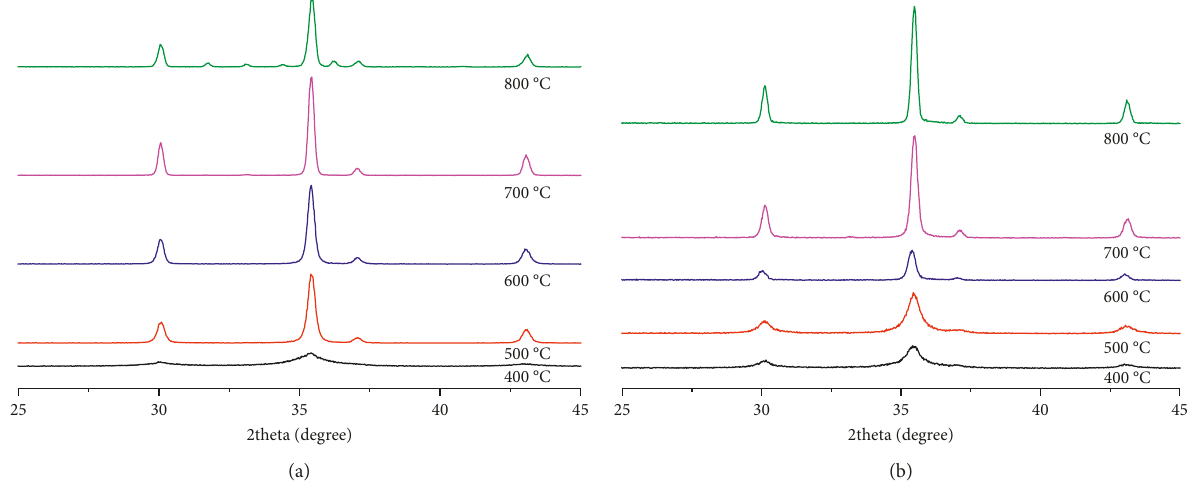
Figure 2: XRD pattern of NZCF04: (a) NZCF04 sol and (b) NZCF04